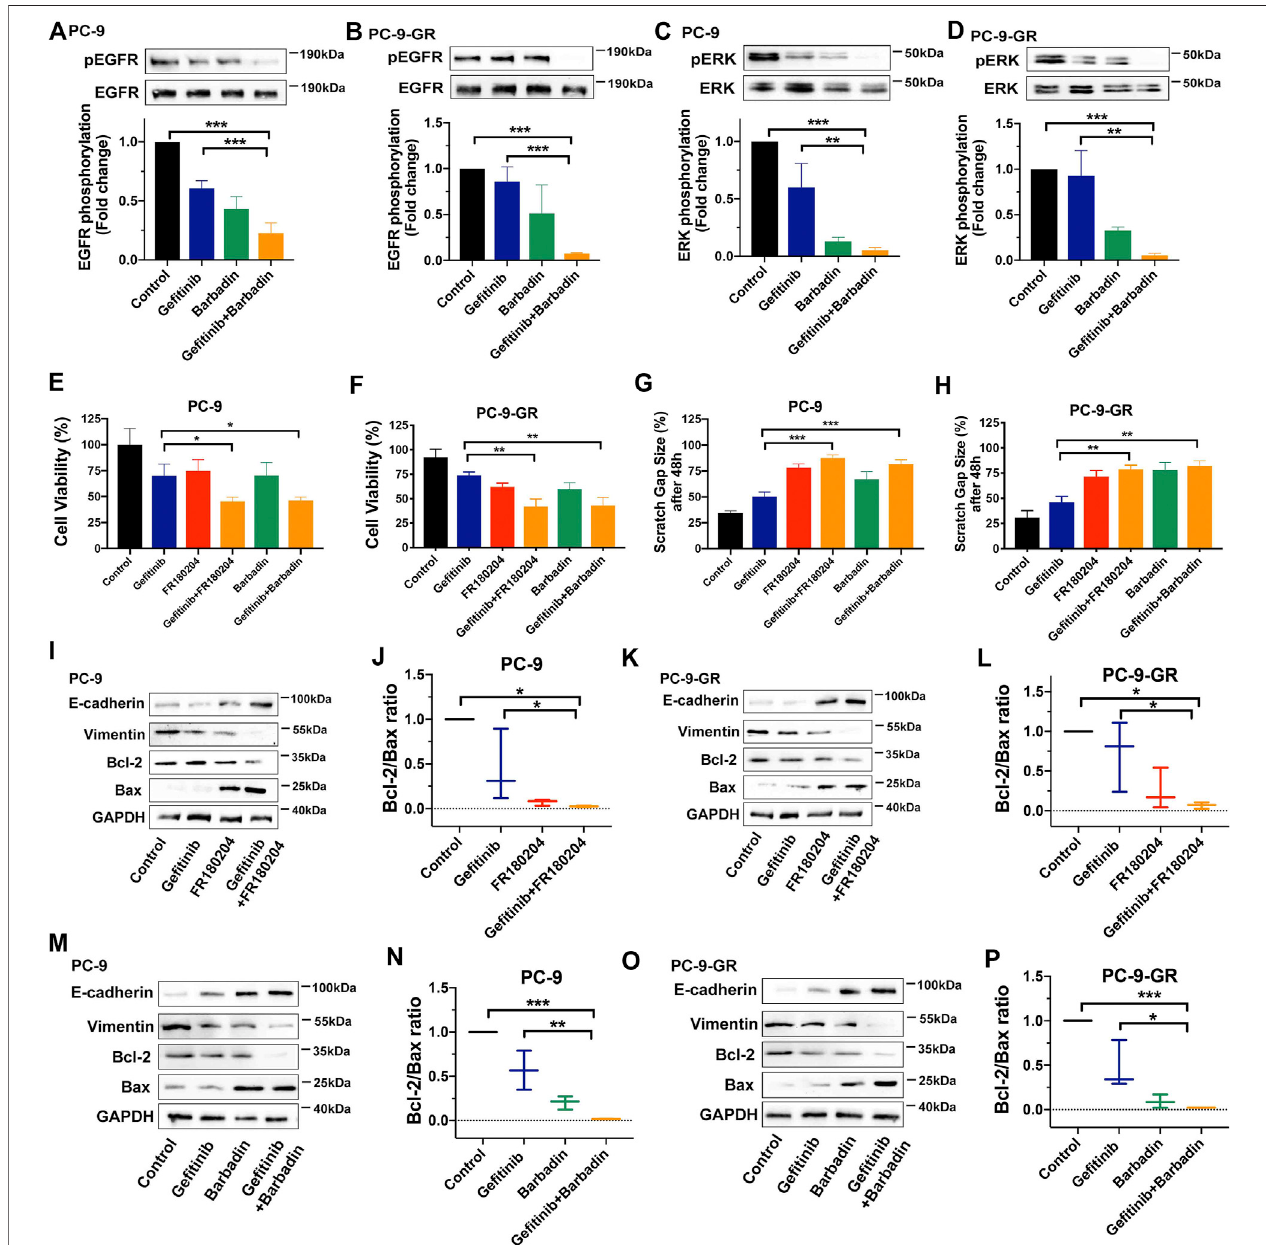
FIGURE4| PAR2reversedNSCLCcellresistanttoge fi tinibvia β -arrestin-EGFR-ERKsignaling. (A – D) .A β -arrestininhibitor(Barbadin,30 μ M)facilitatedge fi tinibto blockphosphorylationofEGFRandERKinPC-9 (A,C) andPC-9-GRcells (B,D) ; (E – F) .EitherbarbardinorERKinhibitor(FR180204,10 μ M)largelyenhancedinhibitory effectsofge fi tinibincellviabilityofPC-9 (E) andPC-9-GR (F) ; (G – H) .BarbadinorFR180204alsopromotedge fi tinibtoattenuatecellmigrationofPC-9 (G) andPC-9-GR (H) ; (I – L) . Addition of FR180204 assisted ge fi tinib to up-regulate or down-regulate expressions of E-cadheirn, vimentin, bcl-2 and bax, suggesting β -arrestin and ERKrelated toPAR2-mediatedEMTandapoptosis (I,K) .Thebcl-2/baxratios werealsocalculated (J,L) ; (M – P) .Barbadinalsoenhacancedge fi tinibtomodulateEMT- or apoptosis-related gene expressions in PC-9 (M) and PC-9-GR cells (O) , while bcl-2/bax ratios were presented (M,P) . * p < 0.05, ** p < 0.01, *** p < 0.001.